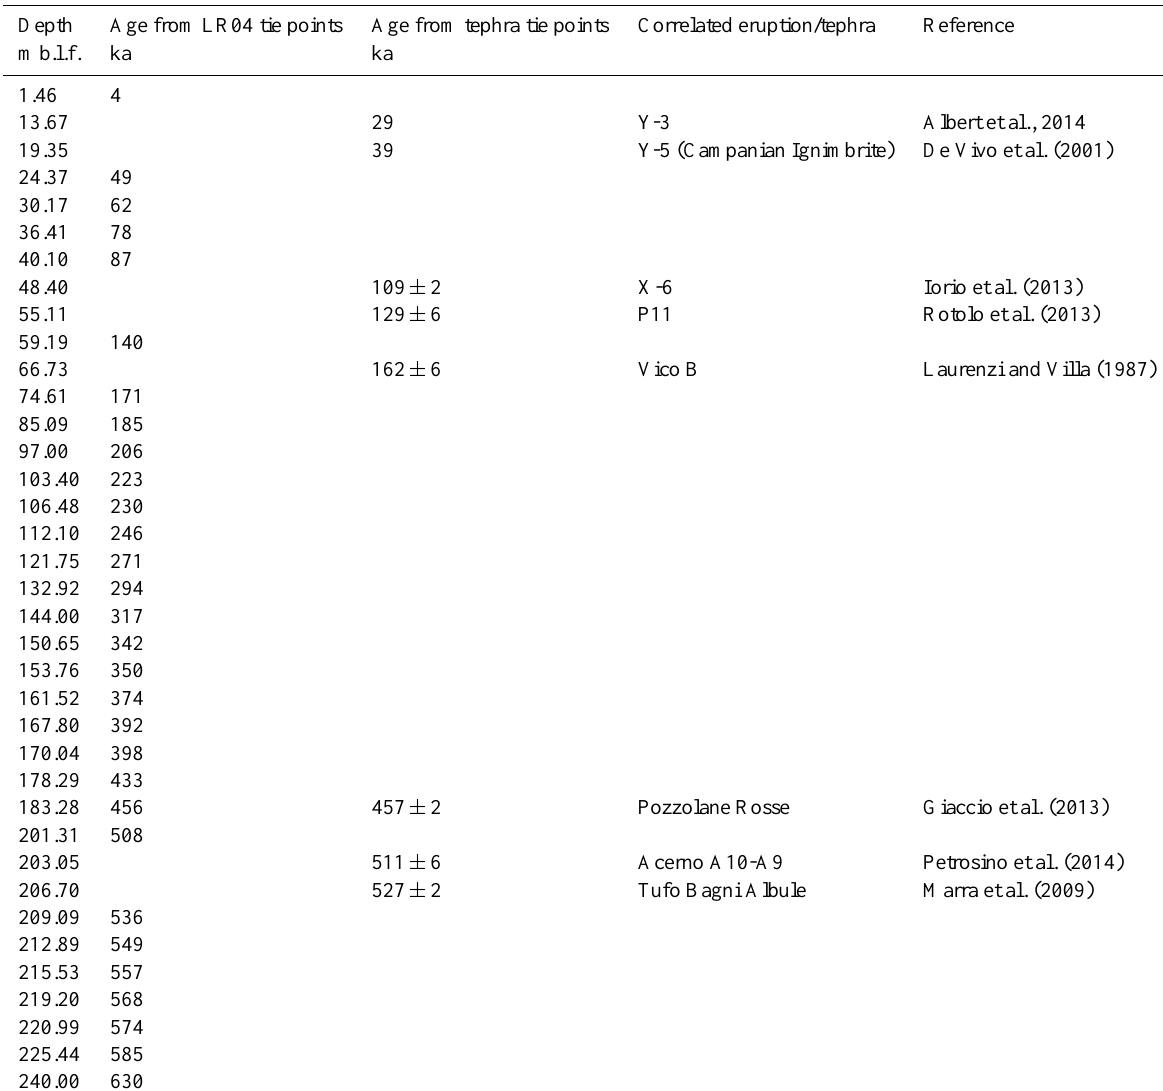
Table 1. Downhole logging data correlated to LR04 (Lisiecki and Raymo, 2005). Eight anchor points from tephrochronology (Leicher et al., 2015) and 30 additional tie points of significant features between the downhole data and LR04 are set. The tephra ages were recalculated (except Y-3) according relative to ACs-2 at 1.193Ma (Nomade et al., 2005) and the total decay constant of Steiger and Jäger (1977), uncertainties are 2 δ . mb.l.f. – metres below lake